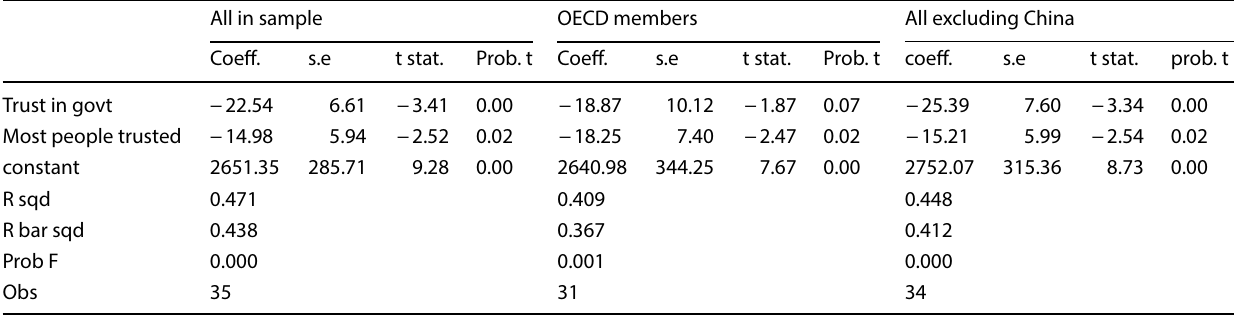
Table 9 Regression results for periods 1 and